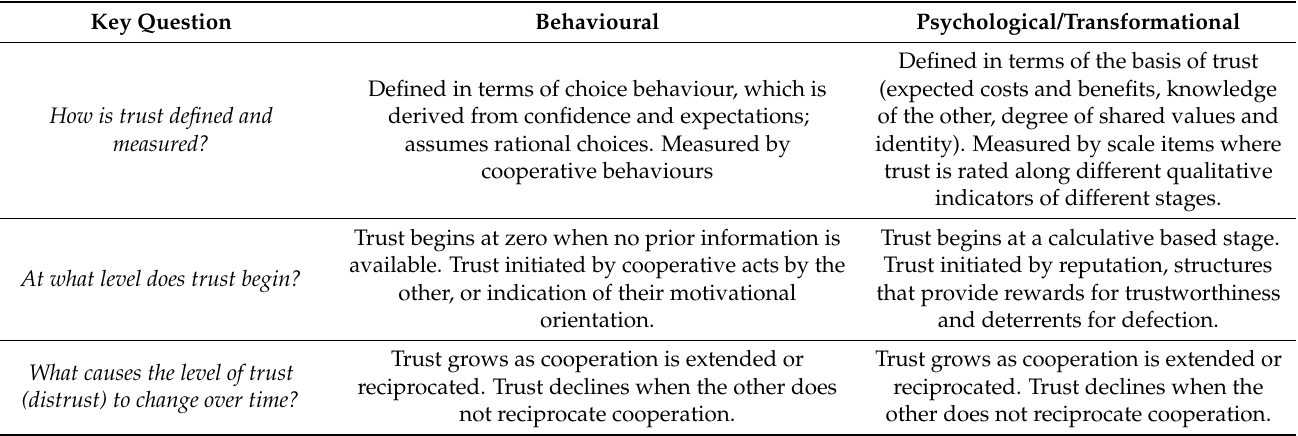
Table 2. Theoretical approaches of trust development. Source: adapted from Lewicki et al.